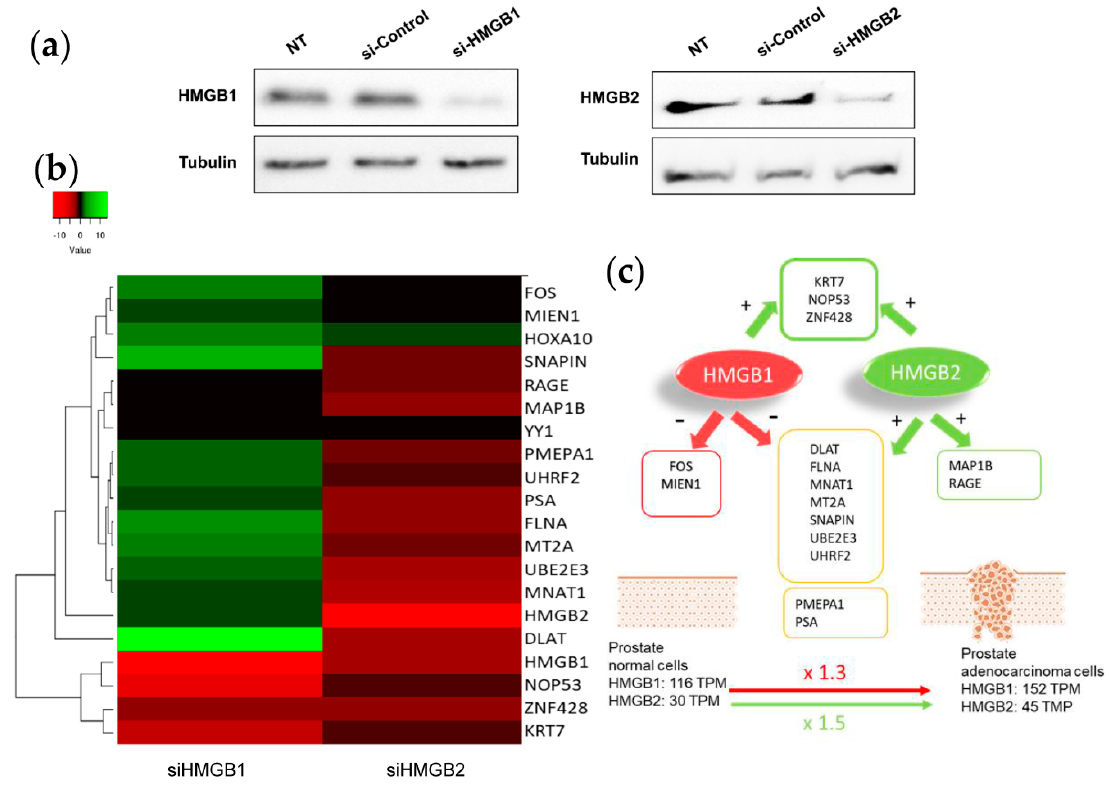
Figure 6. HMGB1 and HMGB2 silencing: ( a ) Western Blot showing HMGB1 and HMGB2 silencing. Complete membranes provided as supplementary material, Image S2 ( b ) Heat map comparing the pattern of expression (siHMGB1/HMGB1 and siHMGB2/HMGB2). ( c ) Summary of regulatory effects of HMGB1 and HMGB2 on the selected genes.